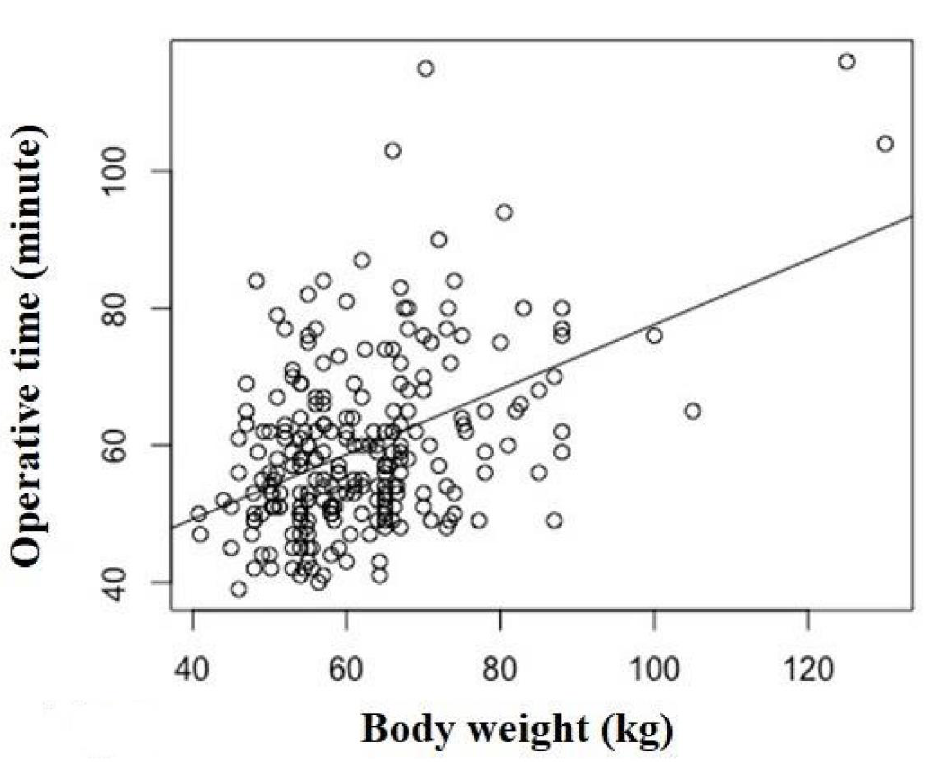
Figure 3. Correlation between operative time and body weight (BW) (r = 0.352, p < 0.001). BW showed a correlation with operative time in the multiple regression analysis. Table 3. Correlations between operative time and the study variables by Spearman’s rank correla- tion